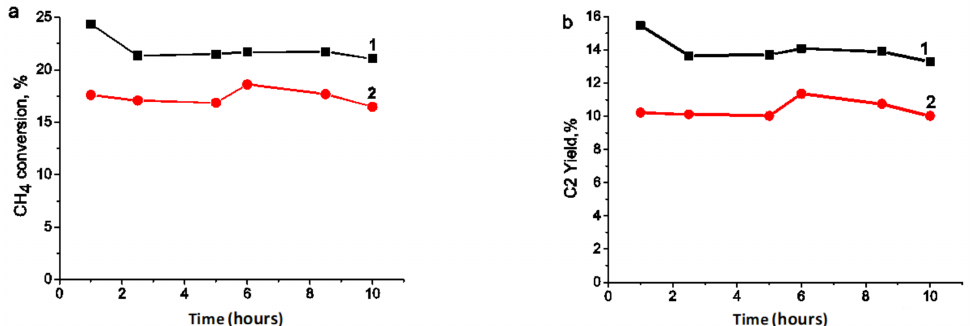
Figure 15. Time dependence of methane conversion ( a ) and C 2 yield ( b ) in OCM for the MA-1 (1) and MA-3 (2) annealed at 1100 ◦ C. The reaction mixture—CH 4 :O 2 :N 2 = 46:11.5:42.5% vol., CH 4 :O 2 = 4, GHSV = 75,000 h − 1 , 800–900 ◦